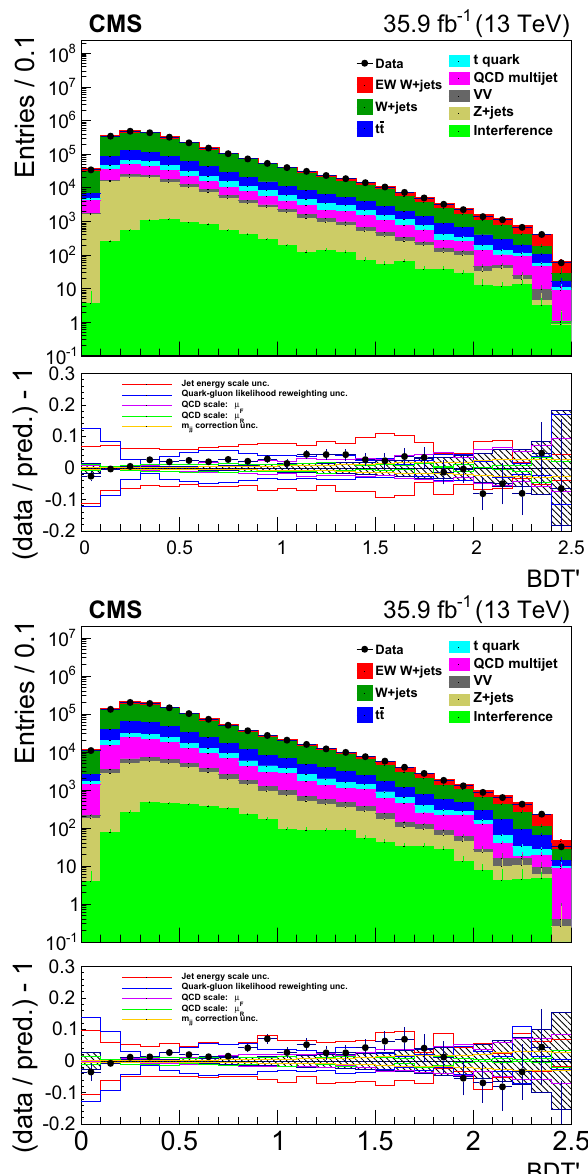
Fig. 8 DataandMCsimulationBDT’outputdistributionsforthemuon (upper) and electron (lower) channels, using the BDT output trans- formed with the tanh − 1 function to enhance the purest signal region. The ratio panel shows the statistical uncertainty from the simulation as well as the independent systematic uncertainties front the leading sources Trigger and selection efficiencies. Uncertainties in the effi- ciency corrections based on control samples in data for theleptonictrigger andofflineselections areincludedand amount to a total of 2–3% depending on the lepton p T and η , for both the e and μ channels. These uncertain- ties are estimated by comparing the lepton efficiencies expected in simulation and measured in data with a “tag- and-probe” method